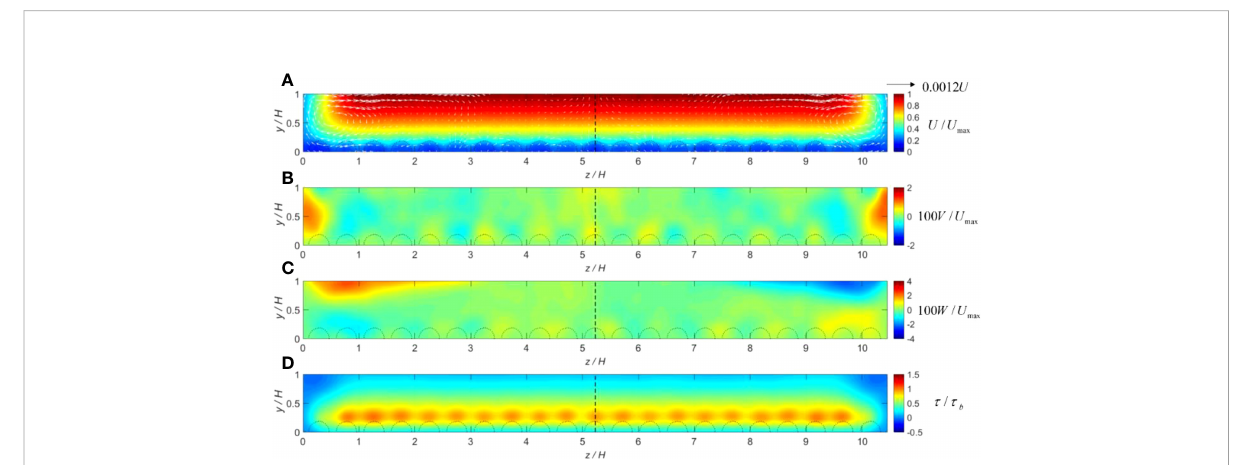
FIGURE 7 (A – D) Cross-sectional distributions of hydrodynamic parameters computed for fl ow condition 1 (shallow depth: Re = 11,200) including the roughness elements: normalized mean (A) streamwise velocity with vector fi eld; (B) vertical velocity; (C) lateral velocity; and (D) shear stress. The dashed semicircles at the bottom of each panel represent the rough bed spheres.